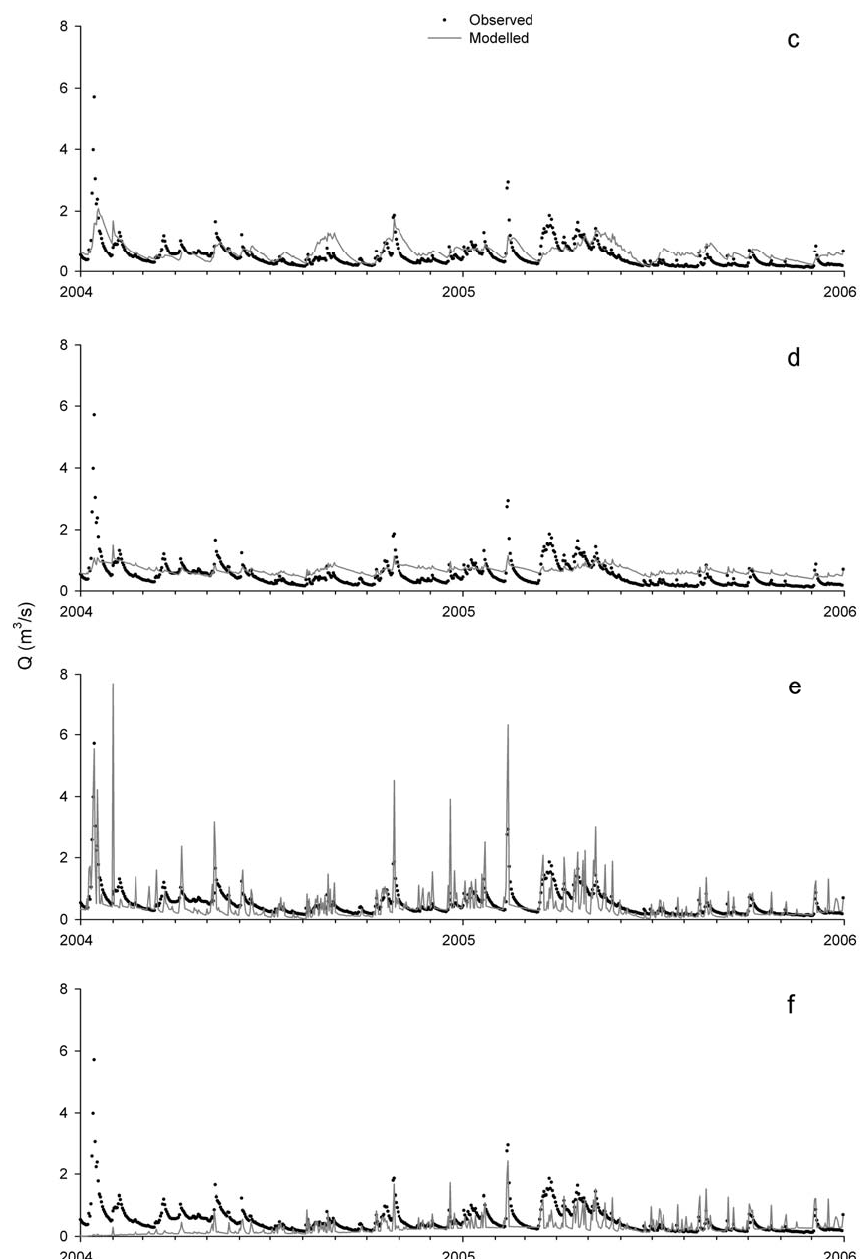
Figure 7. Modelled and observed Zastlerbach hydrographs of the four test parameter sets specified in Table 5. 3